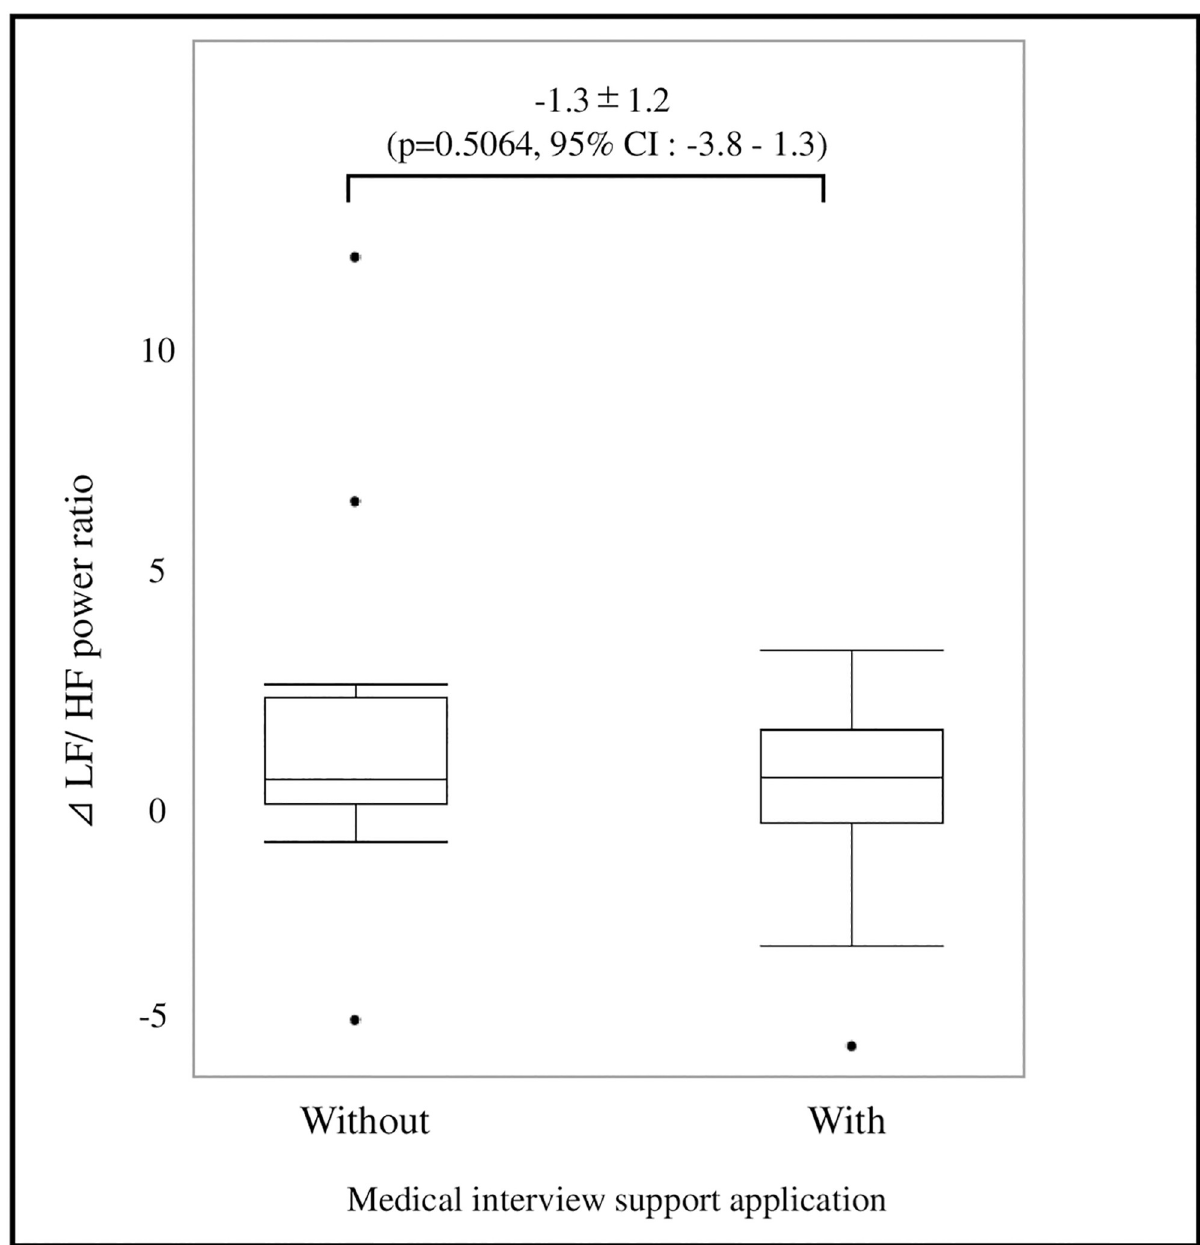
Fig 5. Change in stress scores by medical interview. The change in stress level before and after the interview with and without the interview support application is shown as the ⊿ LF/HF power ratio. The use of the interview support application was not effective in reducing stress.